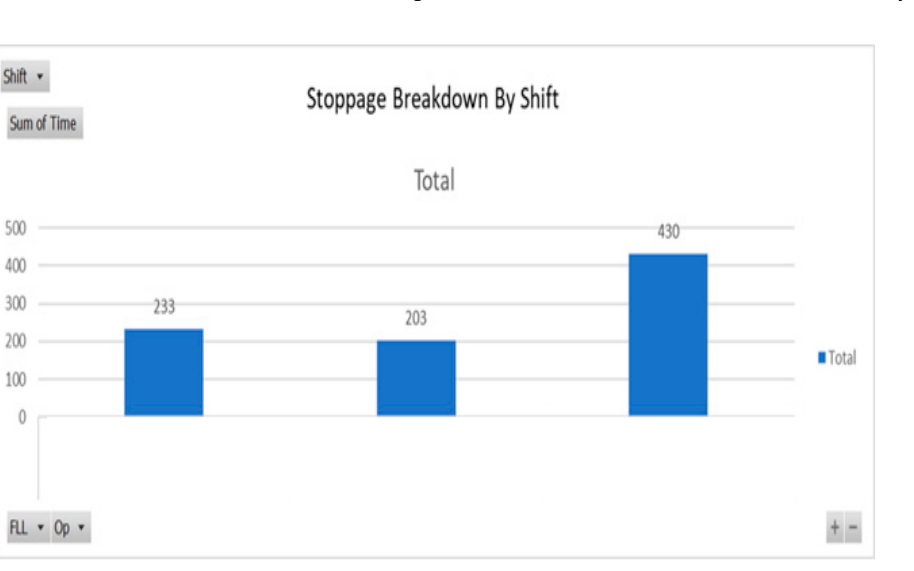
Figure 8. Stoppage Time Breakdown by Shift-comparison of the time lost (in seconds) due to stoppages per shift demonstrated that Shift A (233 s) and shift B (203 s) are practically equal but shift C (430 s) is double the time taken for the other two shifts combined.